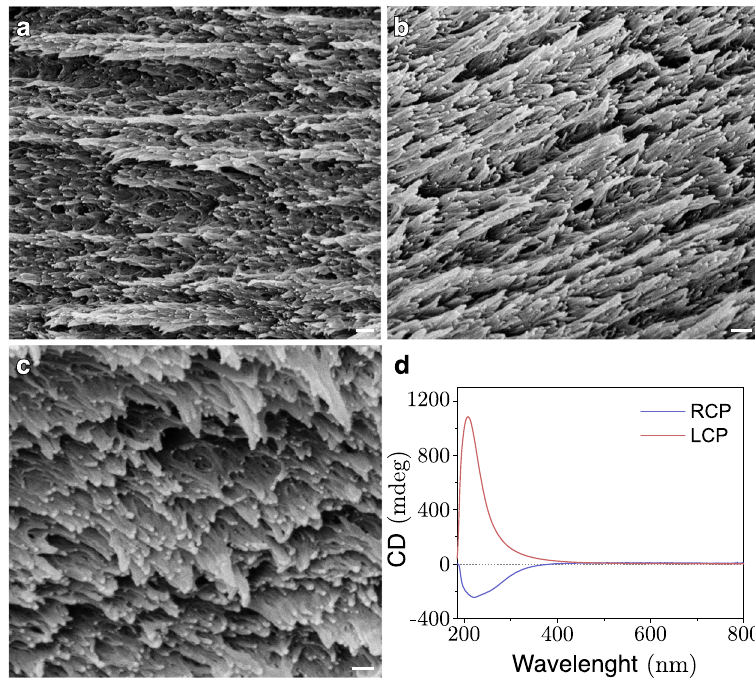
Fig. 4 Cellulose-based nanostructures of solid fi lms from L, N and R solutions. a – c Freeze-fracture SEM cross-section images of the solid fi lms obtained from left-handed (L), when the value of the pitch tends to in fi nity and right-handed (R) liquid crystalline solutions, respectively. Scale bars, 200 nm. d CD spectra of solids fi lms prepared from L and R quasi-2D liquid crystalline